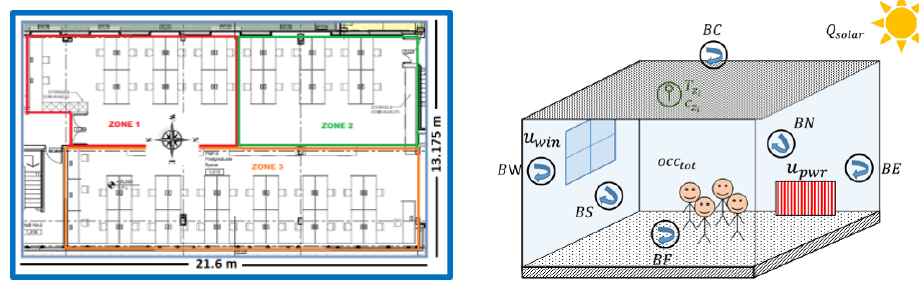
Figure 1. Building with multiple zones ( left ); zone representation with regulated, manipulated and exogenous variables ( right